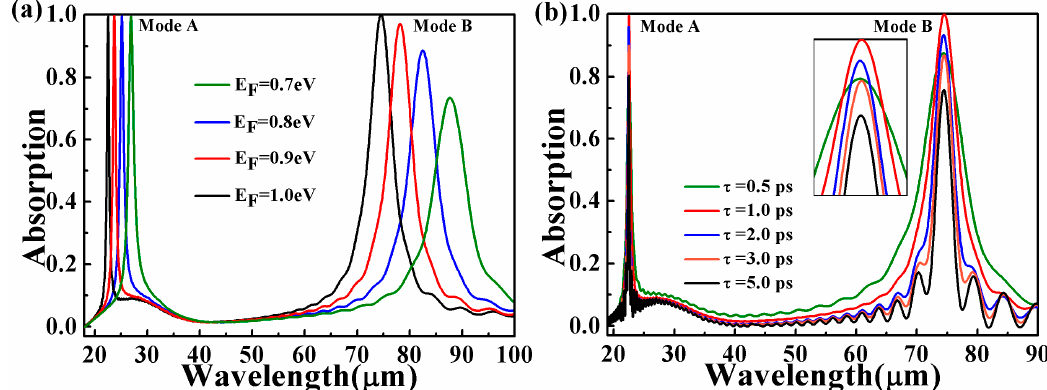
Figure 5. For TM polarization, ( a ) absorption spectrum of the absorber with different Fermi levels (the insert graph is absorption of Mode A) and ( b ) relaxation times. The insert graph is the absorption peak of Mode B.